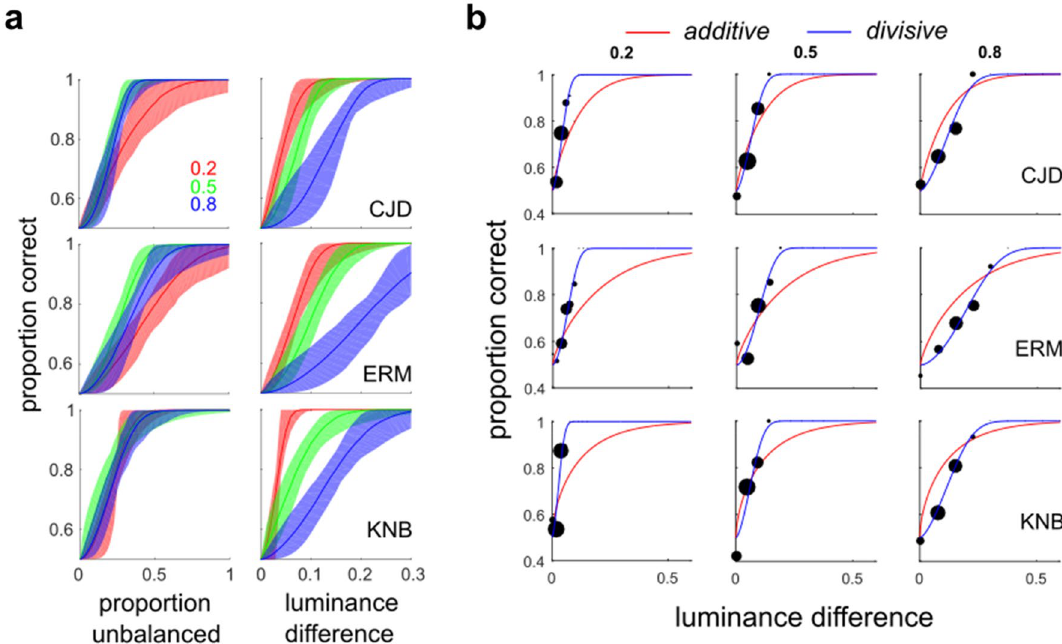
Figure 6. Using micro-pattern amplitude to vary global luminance difference. ( a ) Bootstrapped SDT psychometric function fits (200 bootstrapped re-samplings) with 90% confidence intervals of observer performance as a function of proportion unbalanced micropatterns (left panels) and absolute luminance difference (right panels). This shows that identical luminance differences give rise to significantly different levels of observer performance for the three Michaelson contrasts (right panels), i.e. global luminance difference is a very poor predictor of performance. Instead, observer performance is much better predicted by the proportion of unbalanced micro-patterns, (almost) irrespective of micro-pattern amplitude (left panels). ( b ) Data from Experiment 3 (black dots) and fits of the additive (red) and divisive (blue) image-computable signal detection theory models (IC-SDT) to the data. Each observer was tested at three different maximum micro-pattern amplitudes, which correspond to different Michaelson contrasts (0.2, 0.4, 0.8) of the stimuli. We see that a model incorporating a global luminance difference computation followed by contrast normalization (blue) provides an excellent fit to this